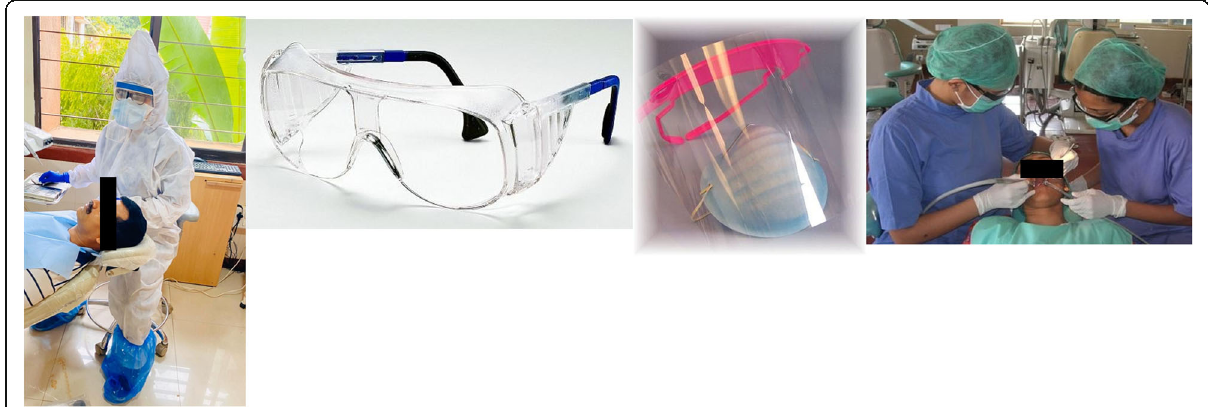
Fig. 3 Protective eyewear with side shields and face shields can protect the eyes from spatter or debris generated during dental